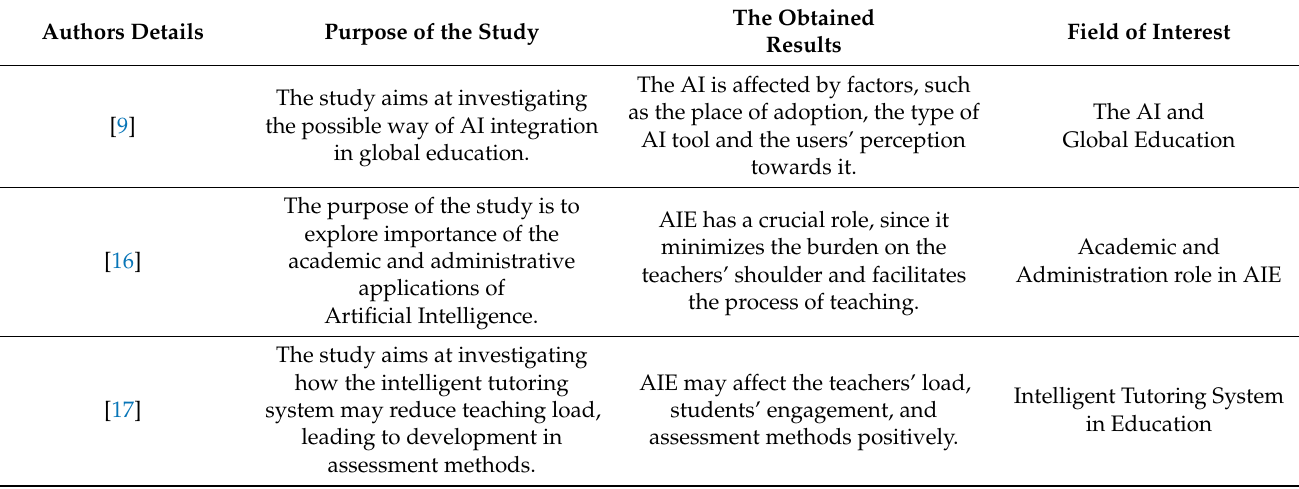
Table 1. Recent AIE studies field of